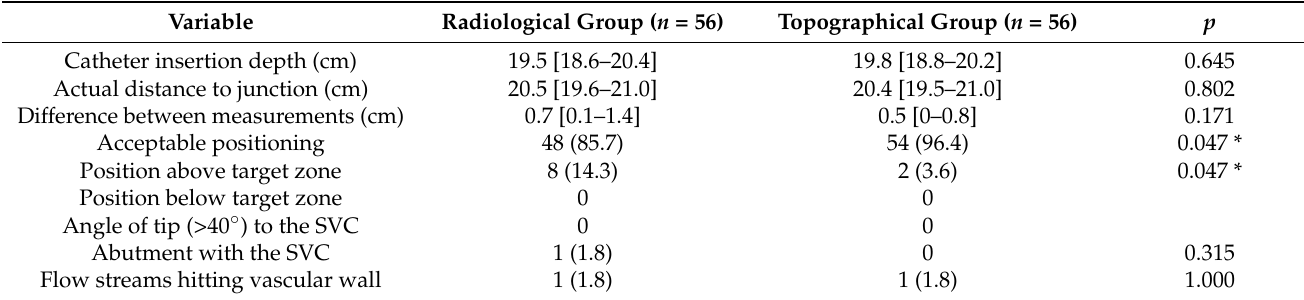
Table 2. Measurement and assessment in catheter positioning.